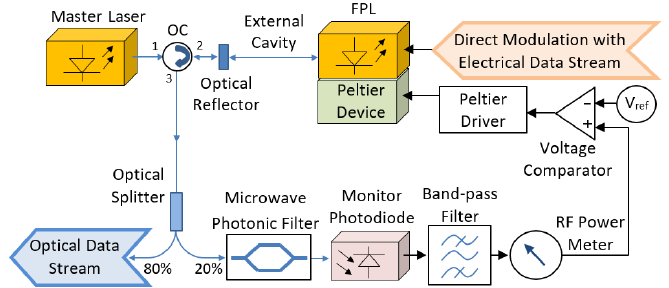
Figure 11. Device for stability supervision of an injection-locked Fabry–Pérot laser